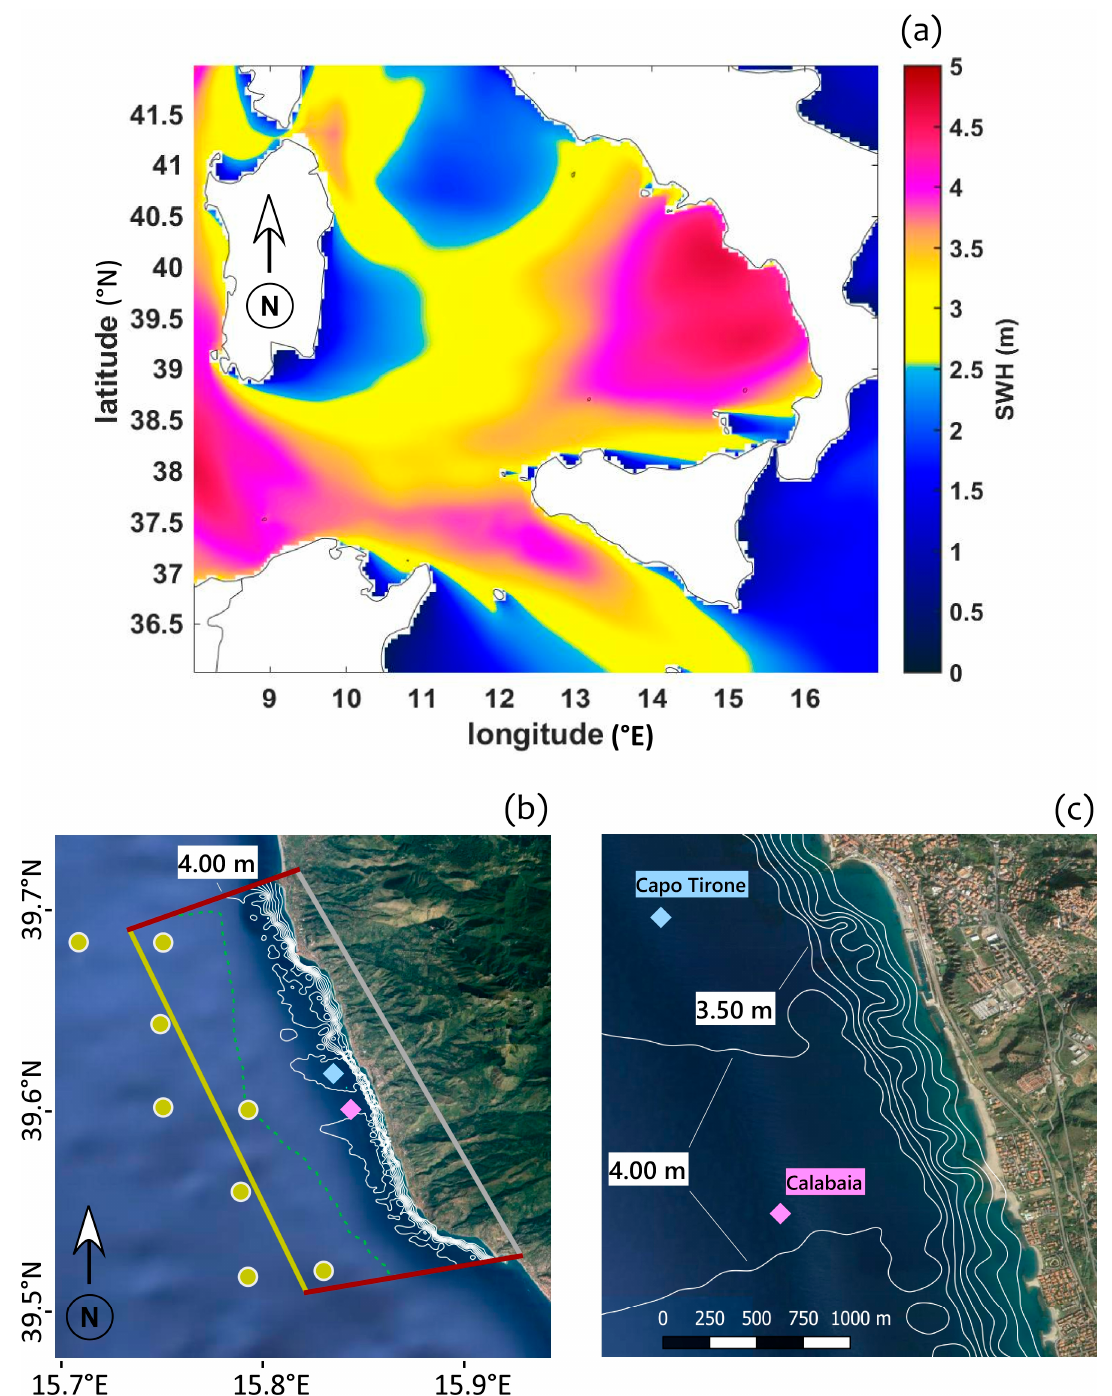
Figure 11. 21 March 2018, 09 UTC. ( a ) WAM domain and spatial distribution of the SWH. ( b , c ) The MIKE domain and the bathymetry of the area. Yellow bullets indicate the output sections, where WAM computes the wave climate; the yellow solid line is the seaward boundary section (SBS, i.e., where MIKE is forced by the SWH computed by WAM in the output sections), the red lines are the two lateral boundary sections (LBS), and the grey line is the coastal boundary section (CBS). Blue (Capo Tirone) and purple (Calabaia) rhombi illustrate the two sites eligible for buoy